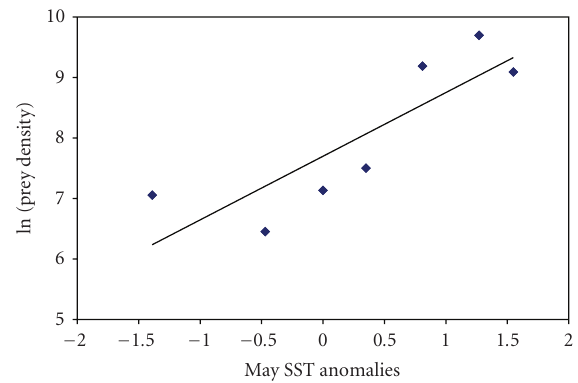
Figure 4: The relationship between the natural logarithm of prey density and indices of May sea surface temperatures (SST)